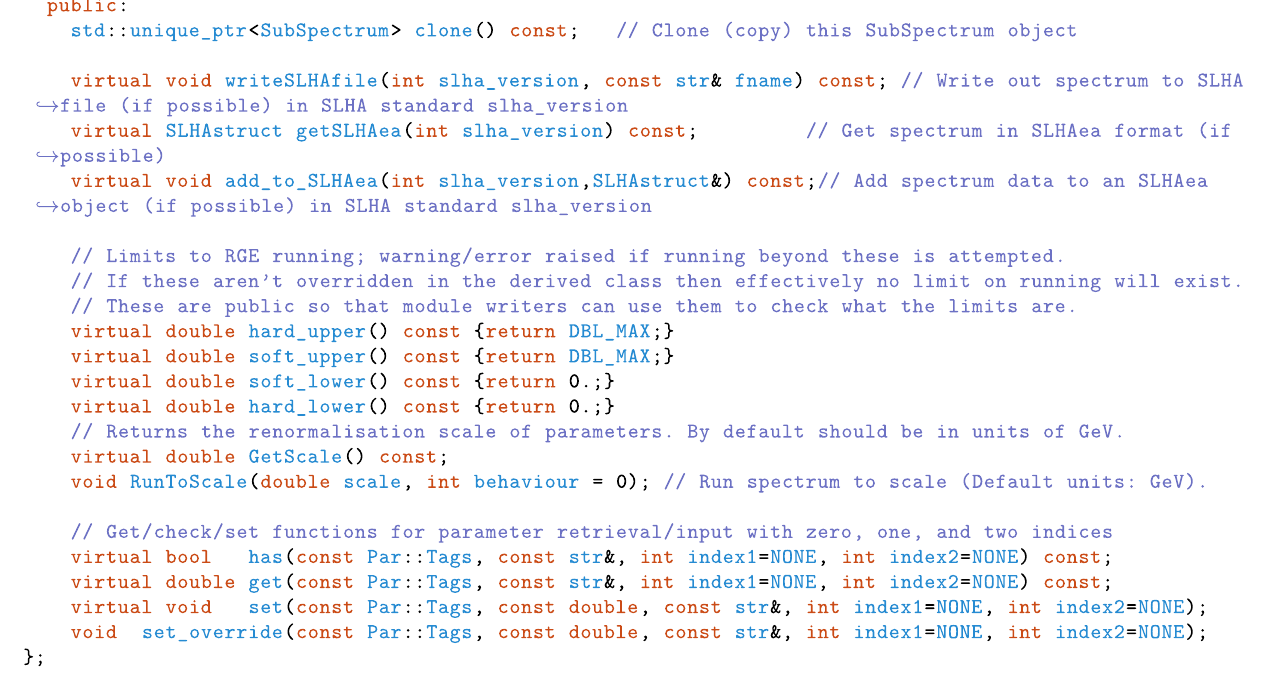
Fig. 6 Simplified class definition of SubSpectrum class, which is the virtual base class for interacting with spectrum genera- tor output, including an interface for running RGEs. Not shown are various overloads, constructors, helper functions, and all pri- vate members. The index arguments for the has / get / set func-